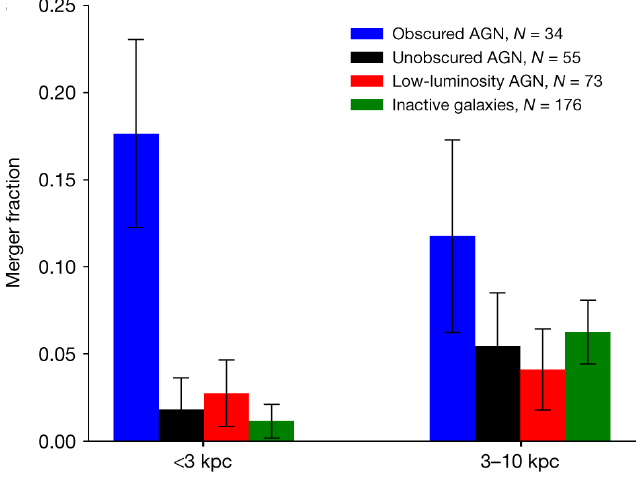
Figure 15. Distributions of close mergers at the < 3 kpc and 3–10 kpc separations, respectively, as categorized by the presence of broad H recombination lines from optical spectroscopy and bolometric luminosity as computed from X-ray emission. There is clearly an excess of nuclear mergers among obscured AGN at close separations. Figure adapted from Koss et al. [254] with